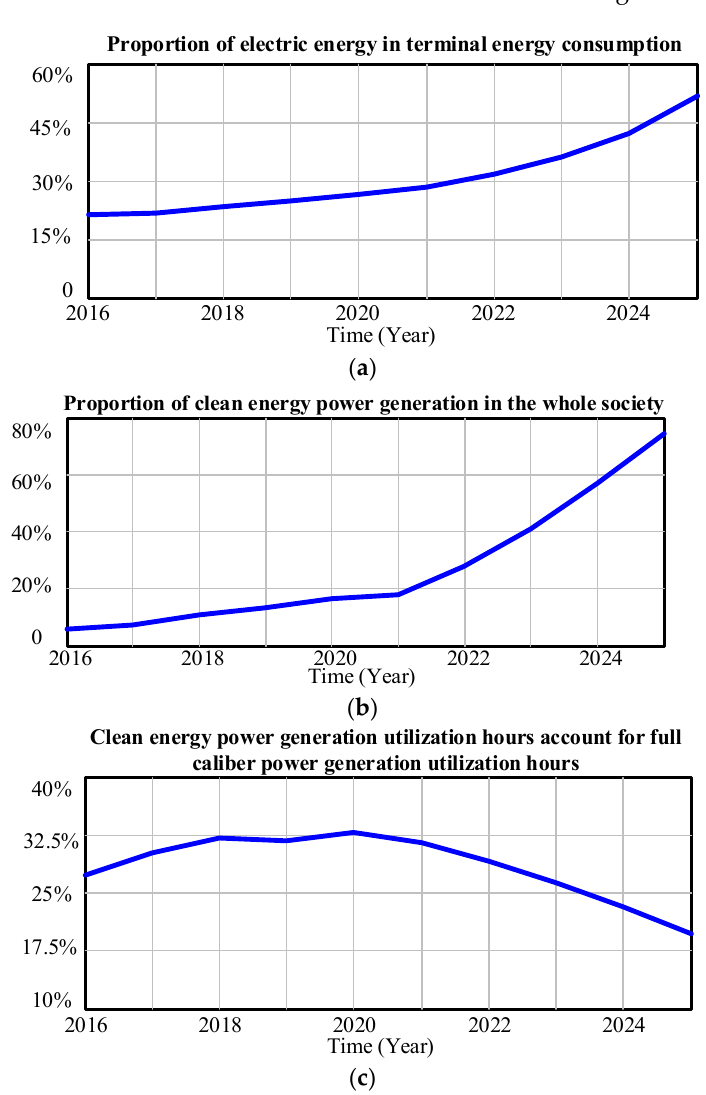
Figure 8. ( a ) The predicted value of the proportion of electric energy in terminal energy consumption from 2016 to 2025; ( b ) Predicted value of the proportion of clean energy power generation in the whole society from 2016 to 2025; ( c ) The predicted value of clean energy power generation utilization hours account for full caliber power generation utilization hours from 2016 to 2025.